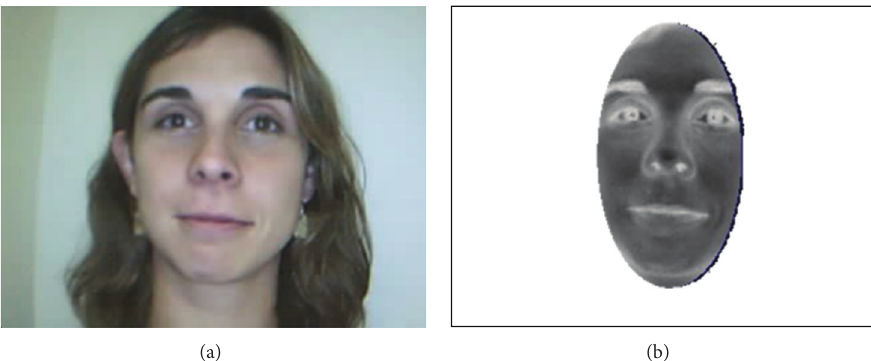
Figure 2: Vision based interface. (a) Image obtained by the webcam interface at a resolution of 320 × 240 pixels. (b) Ellipse ROI image obtained after the skin detection (in YCbCr space) and the ellipse calculation.